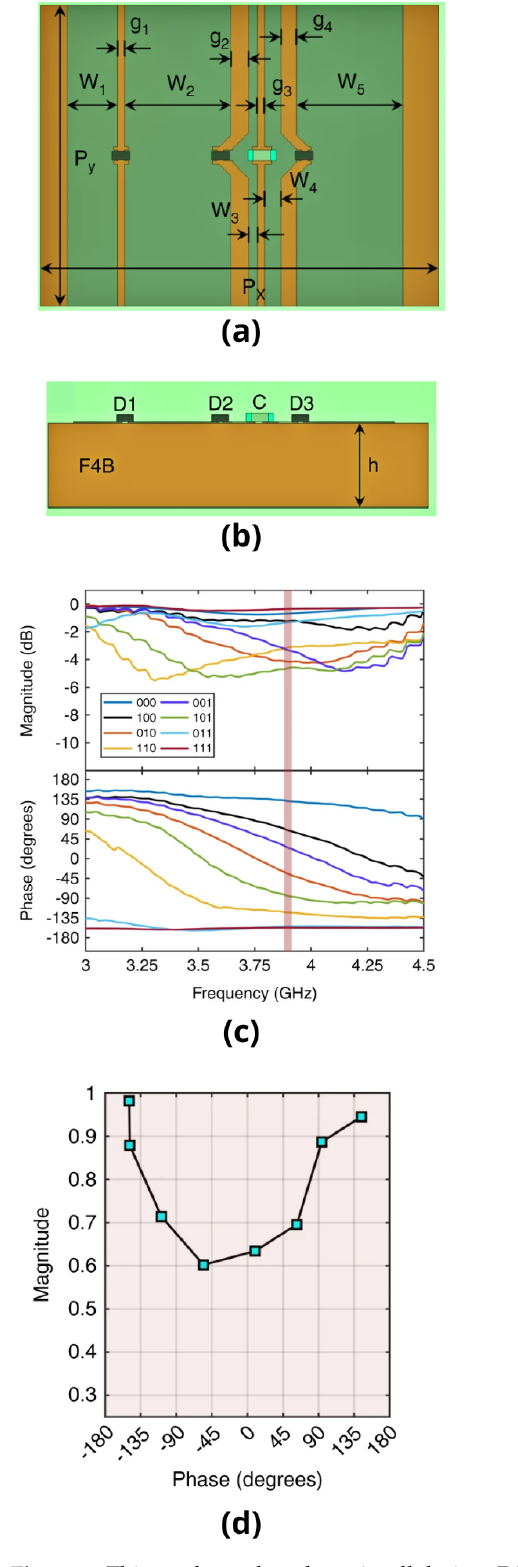
Figure 2. This work employed a unit cell design. Dimensions for the ( a ) front view and ( b ) cut view. The graph in ( c ) displays the deliberate reflection response as a frequency function for the eight-pin diode setups. The phase against magnitude plot at 3.9 GHz in graph ( d ) illustrates the IRS significant phase-dependent magnitude response